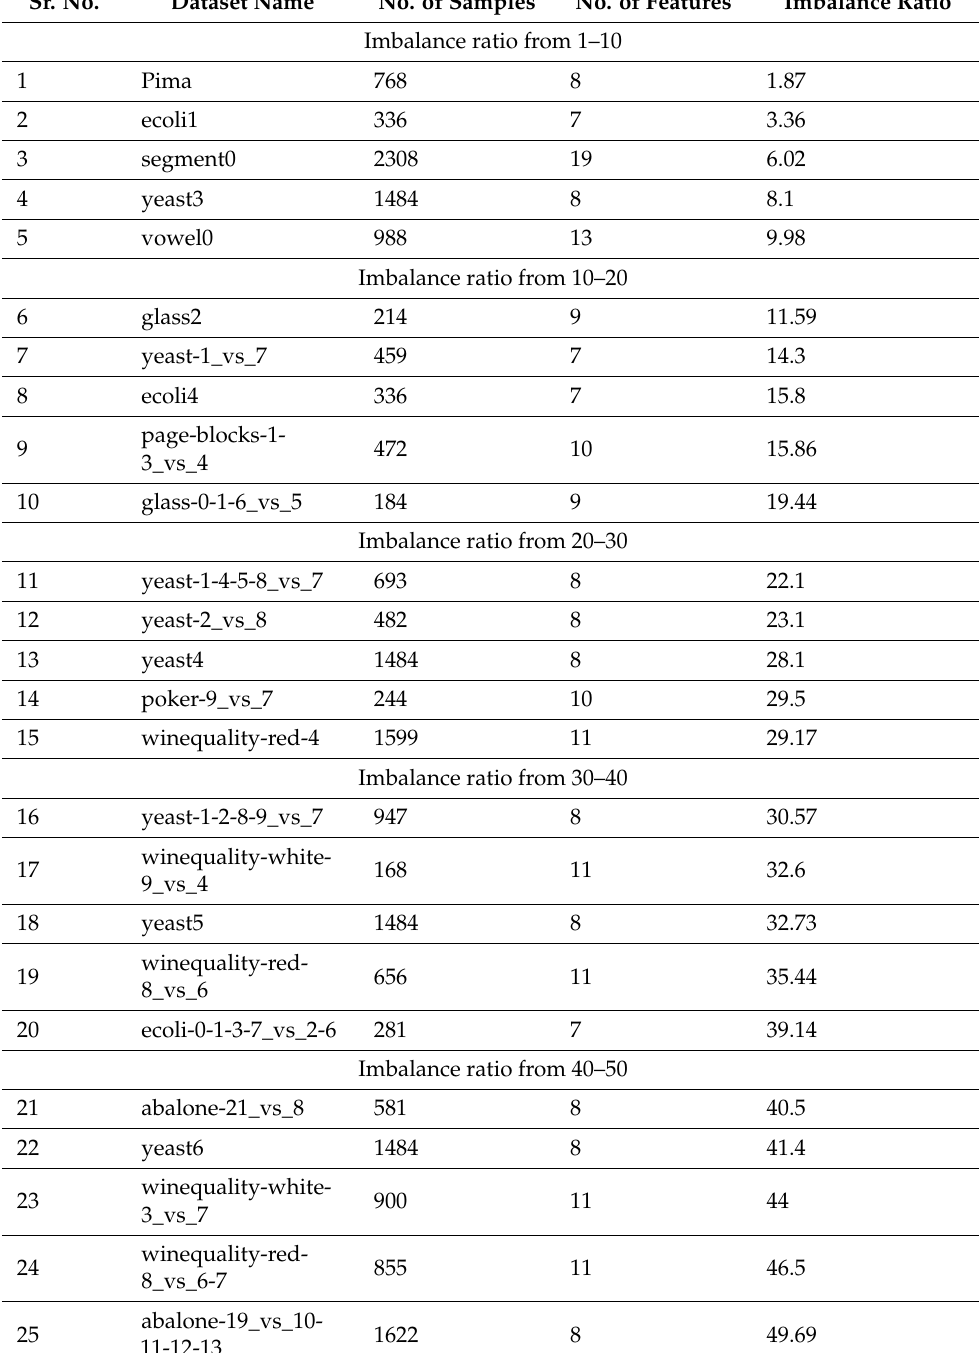
Table 1. Dataset